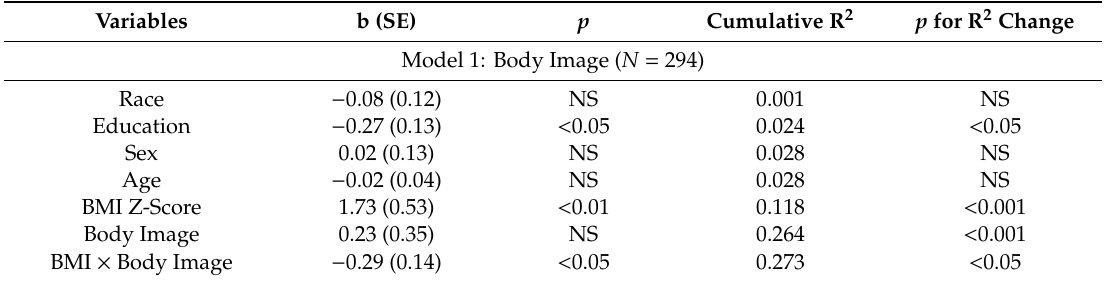
Table 4. Regression Analysis Models with Interactions Predicting Frequency of Weight-Related